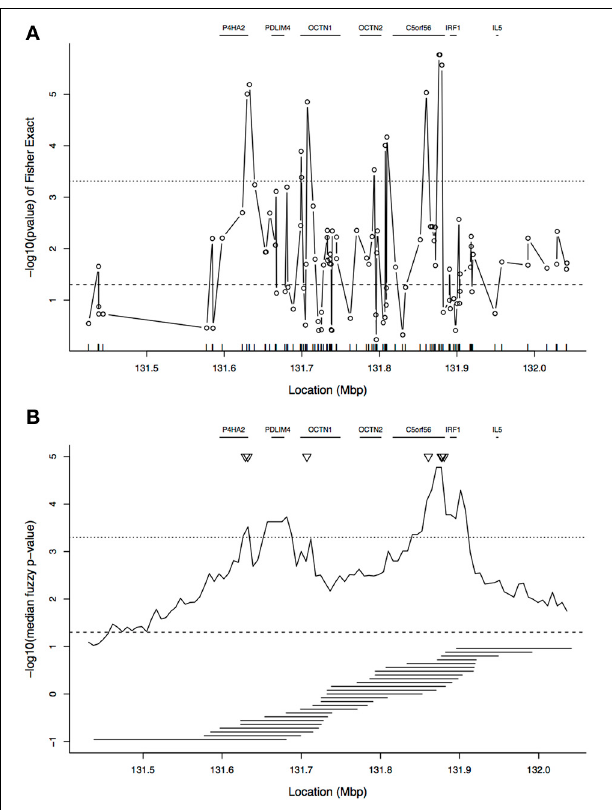
FIGURE 3 | Plot of association results in the 5q31 region. (A) Single-SNP analysis: plot shows − log 10 (p-value) from Fisher’s exact test of association between allelic state and case/control status. The tickmarks at the base of the plot show the locations of the SNPs. (B) Tree-based analysis: − log 10 of the median of the fuzzy p -value by focal point. In (B) , the tiled horizontal line segments under the association curve show the window spans for every second focal point. In both panels, gene locations are indicated at the top of each panel. The horizontal dotted line near y = 3 . 3 indicates a p -value of 0.05 after Bonferroni correction, and the horizontal dashed line near y = 1 . 3 is the uncorrected p -value threshold of 0.05. The Bonferroni correction for (A) is based on 103 SNPs and for (B) it is based on 100 focal points. The triangles in (B) correspond to the peaks of (A)